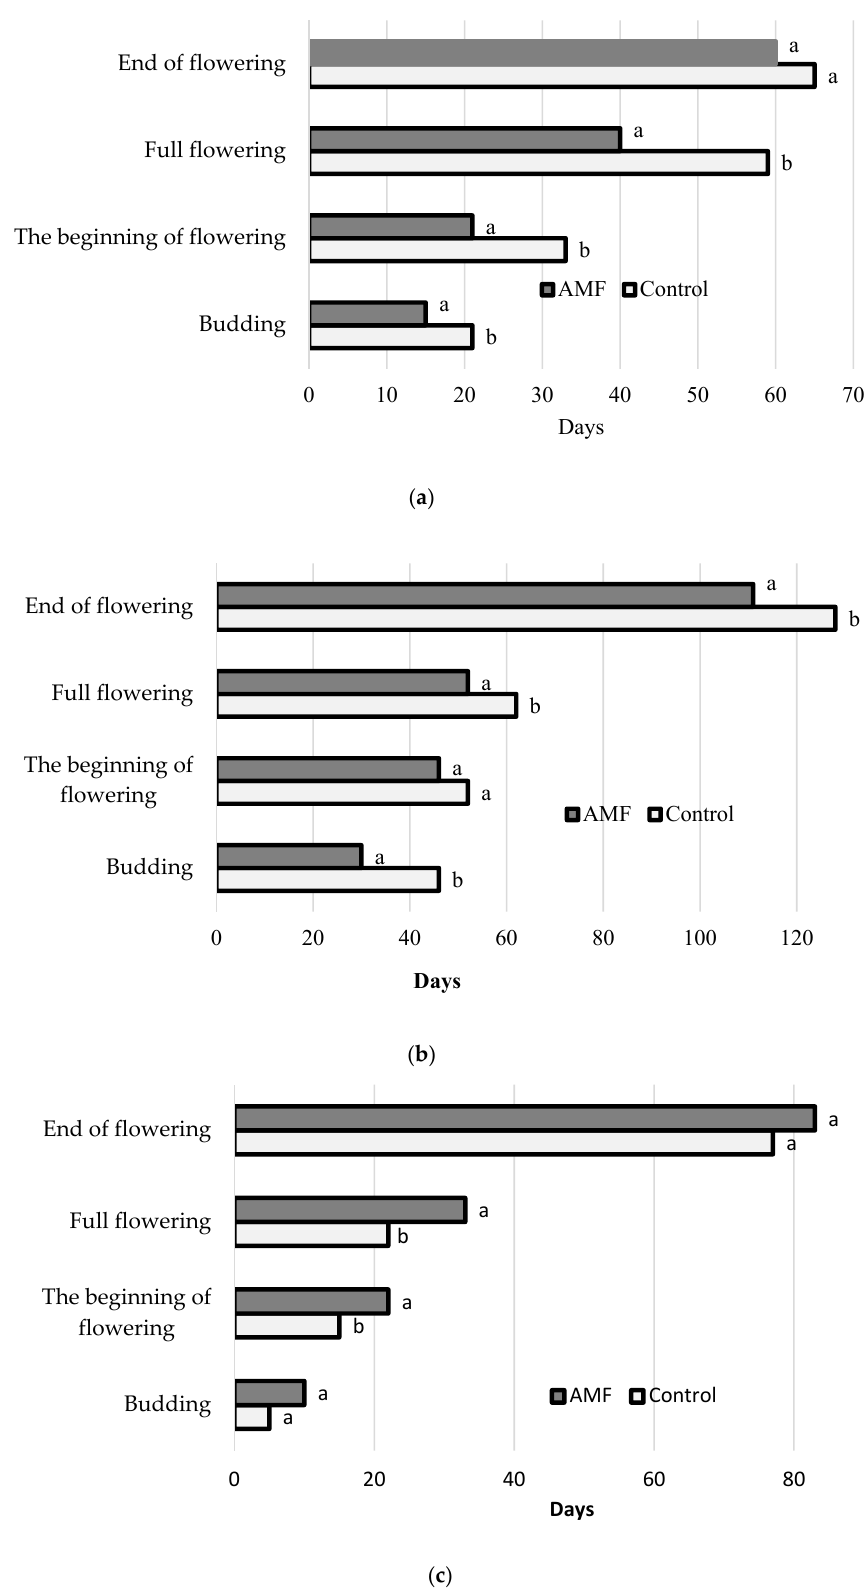
Figure 1. Effect of arbuscular mycorrhizal fungi (AMF) inoculation on aromatic plant phenological development: ( a ) A. dracunculus ; ( b ) L. angustifolia ; ( c ) H. officinalis. Values followed by different letters are statistically different, according to Duncan’s test, at p ≤ 0.05.